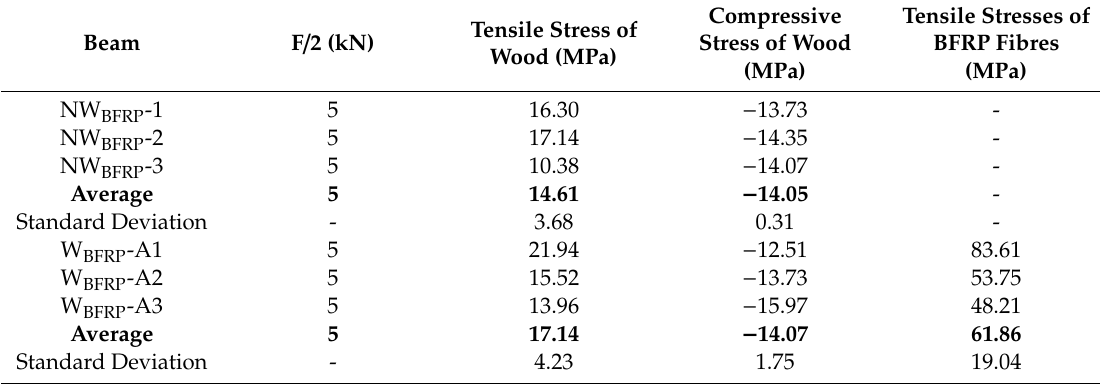
Table 4. The results of tensile and compressive stresses for a series of wooden